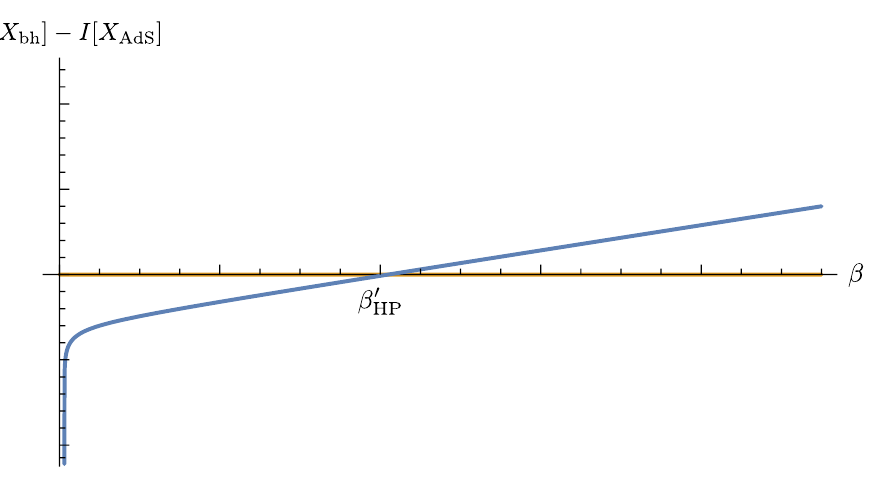
Figure 7 . There is an exchange in dominance between the black wormhole X bh and the AdS worm- hole X AdS , at β = β 0 . In d = 2 , we have numerically checked that β 0 HP